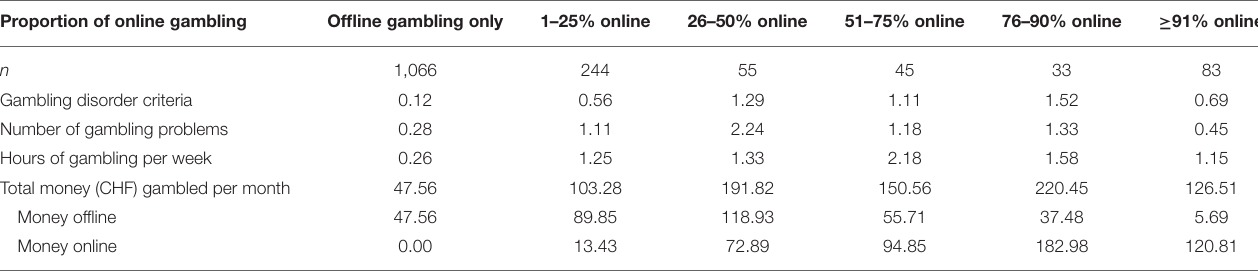
TABLE 2 | Gambling disorder criteria, gambling problems (financial problems, mental stress, problems at work, etc), gambling frequency and money used by proportion of money gambled online (among gamblers, N = 1,526). Proportion of online gambling